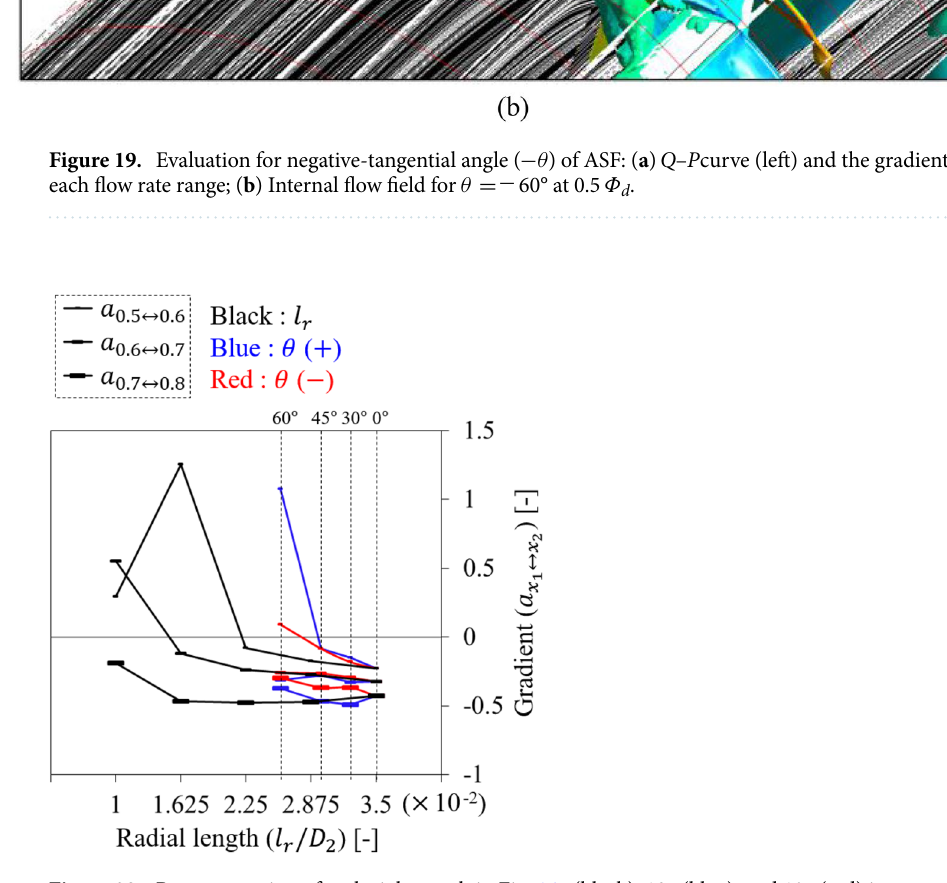
Figure 20. Re-presentation of each right graph in Fig. 14a (black), 18a (blue), and 19a (red) in terms of radial length ( l r